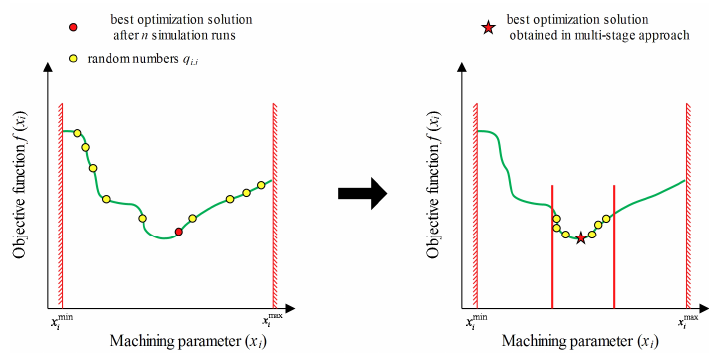
Fig. 1. Illustration of MC optimization procedure in single and multi-stage